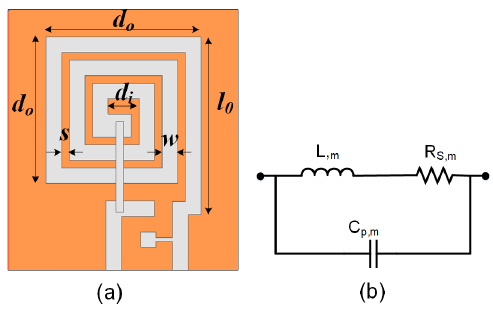
Figure 2. ( a ) Layout of the designed spiral coil and the related representative dimensions, ( b ) electrical model of the receiver (RX)